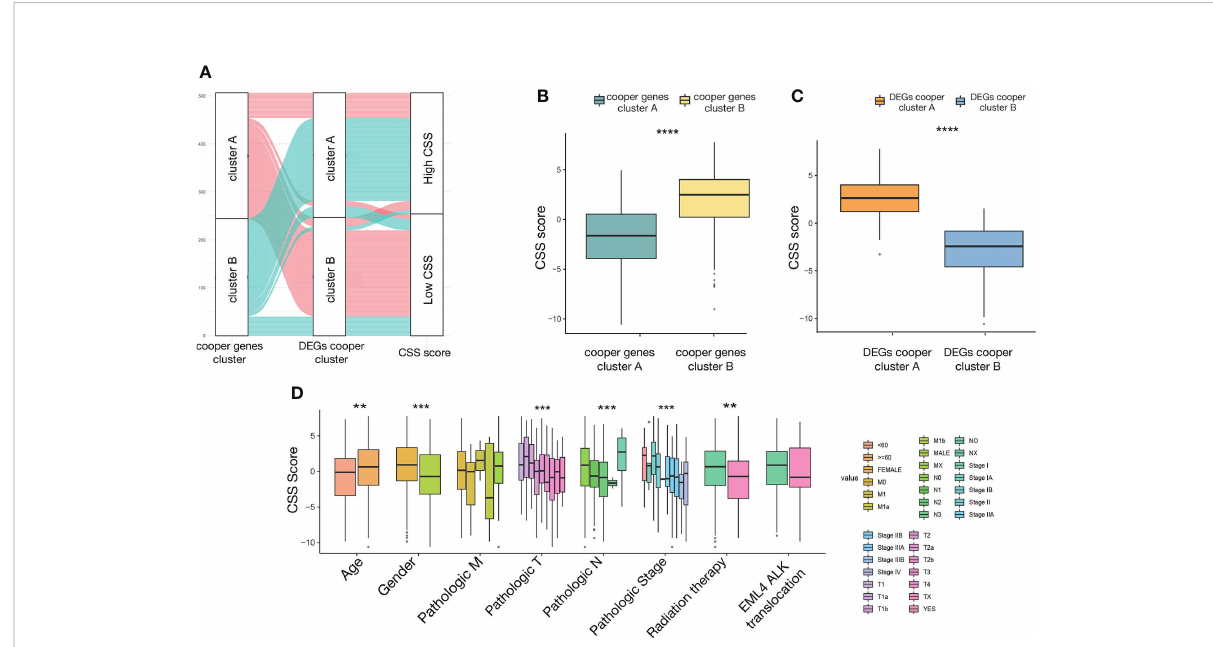
FIGURE 7 The relationship between CSS value and clinicopathological variables in LUAD. (A) alluvial diagram showing the distribution of patients in the two cuproptosis consensus clusters, two cuproptosis related DEGs subtypes, and two CSS score groups. (B) Differences in CSS value between two cuproptosis consensus clusters. (C) Differences in CSS value between two DEGs subtypes. (D) Differences in CSS value between different clinical characteristics. **P<0.01, ***P<0.001, ****P<0.0001. CSS, cuproptosis scoring system; LUAD, lung adenocarcinoma; DEGs, differentially expressed